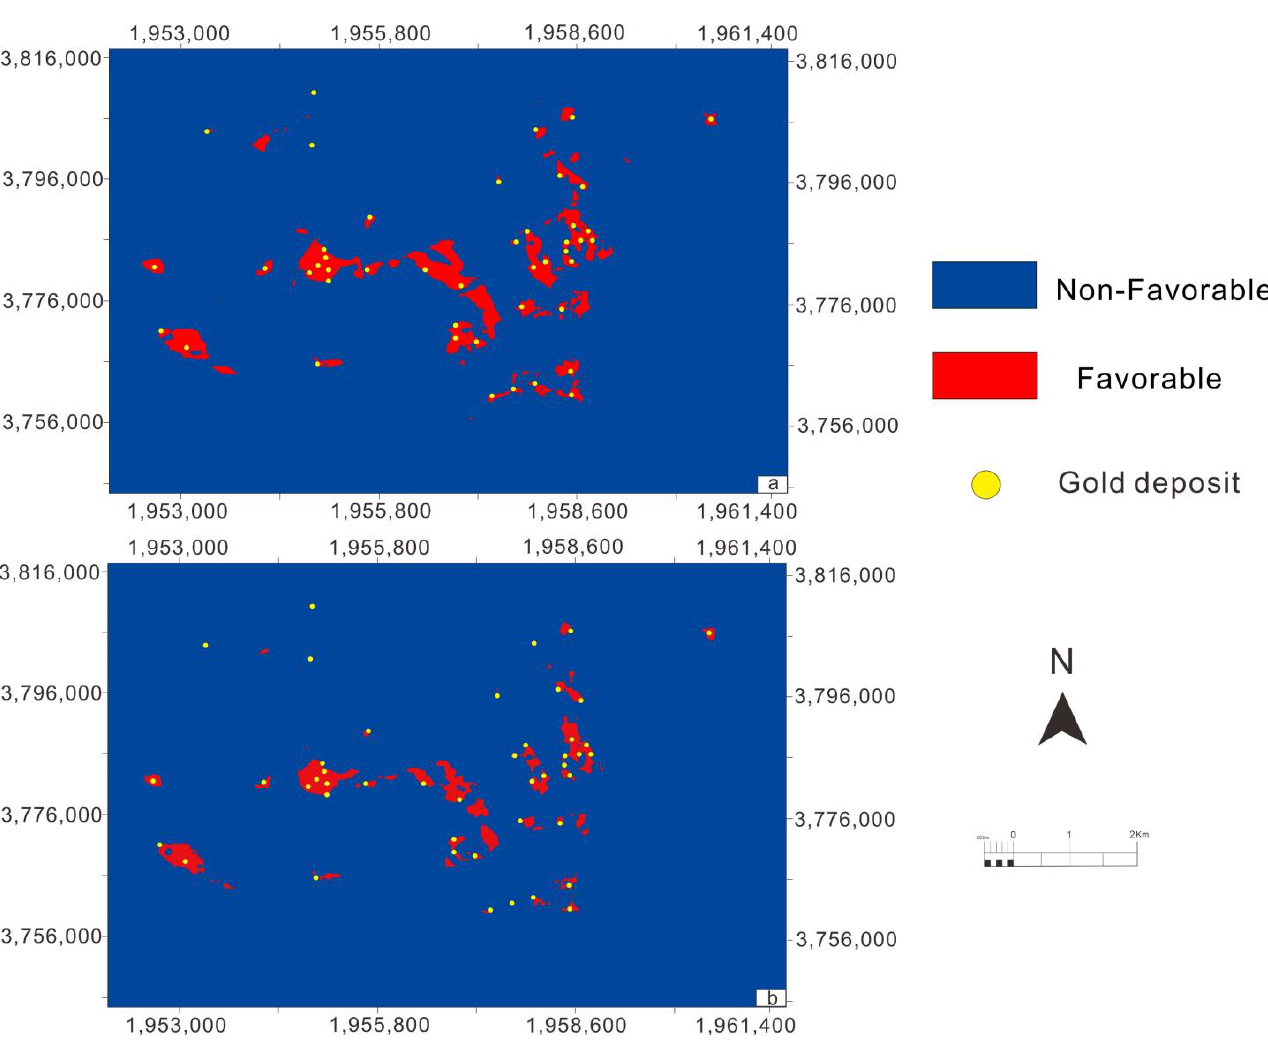
Figure 13. Predictive maps of: ( a ) random search-GBDT; and ( b ) TPE-GBDT models, showing favorable and non-favorable areas by a threshold value of the Max Youden index.